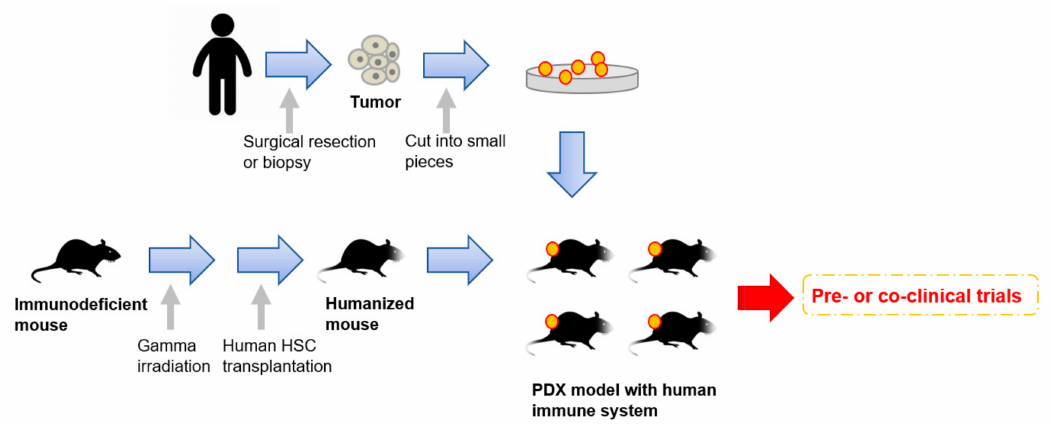
Figure 1. An overall procedure for the generation of PDX models engrafted with a human immune system. Humanized mice are generated by a human hematopoietic stem cells (HSC) transplantation into irradiated immunodeficient mice. Patient-derived tumors obtained by surgical resection or biopsy are sliced into small pieces and then transplanted into the humanized